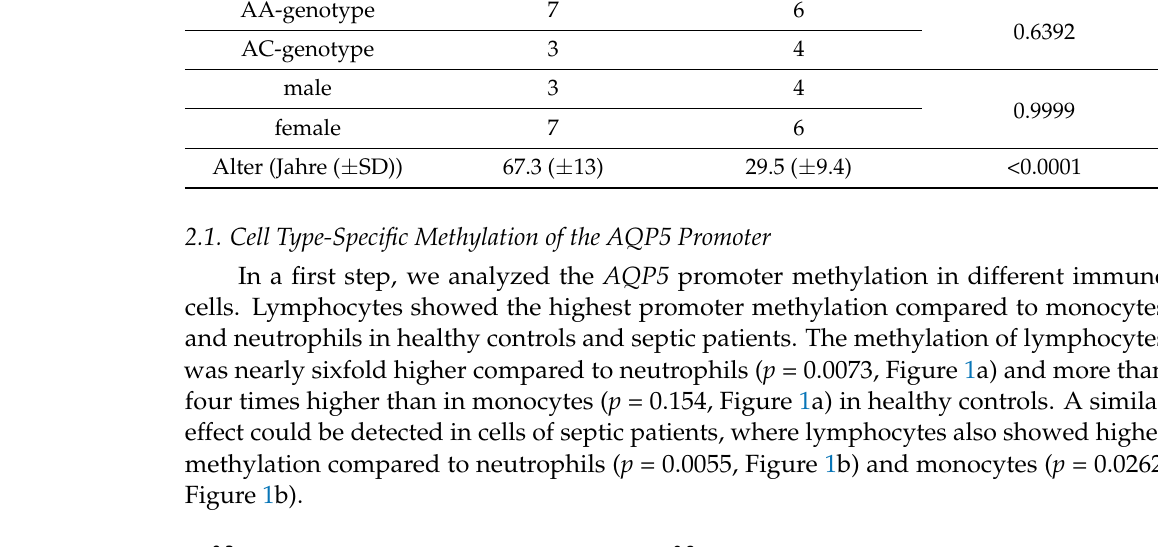
Table 2. Comparison between septic patients and healthy controls.